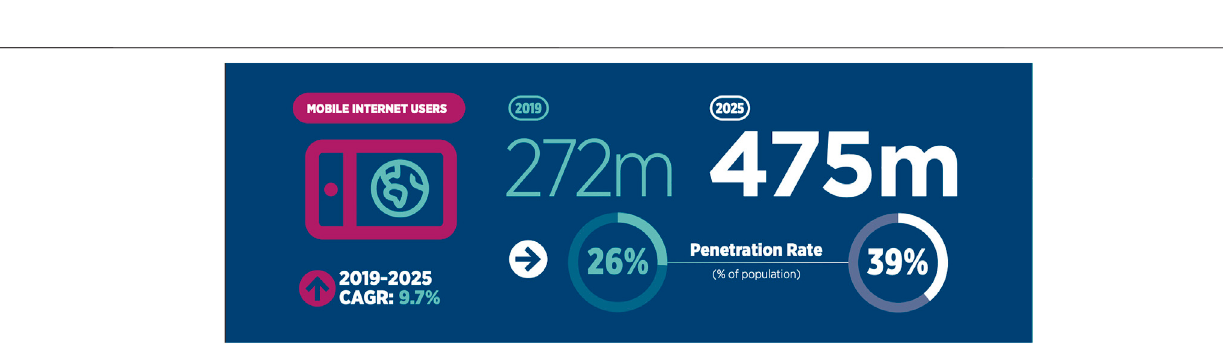
FIGURE 1 | Sub-Saharan SIM connections [GSMA Intelligence (Intelligence, 2020)].